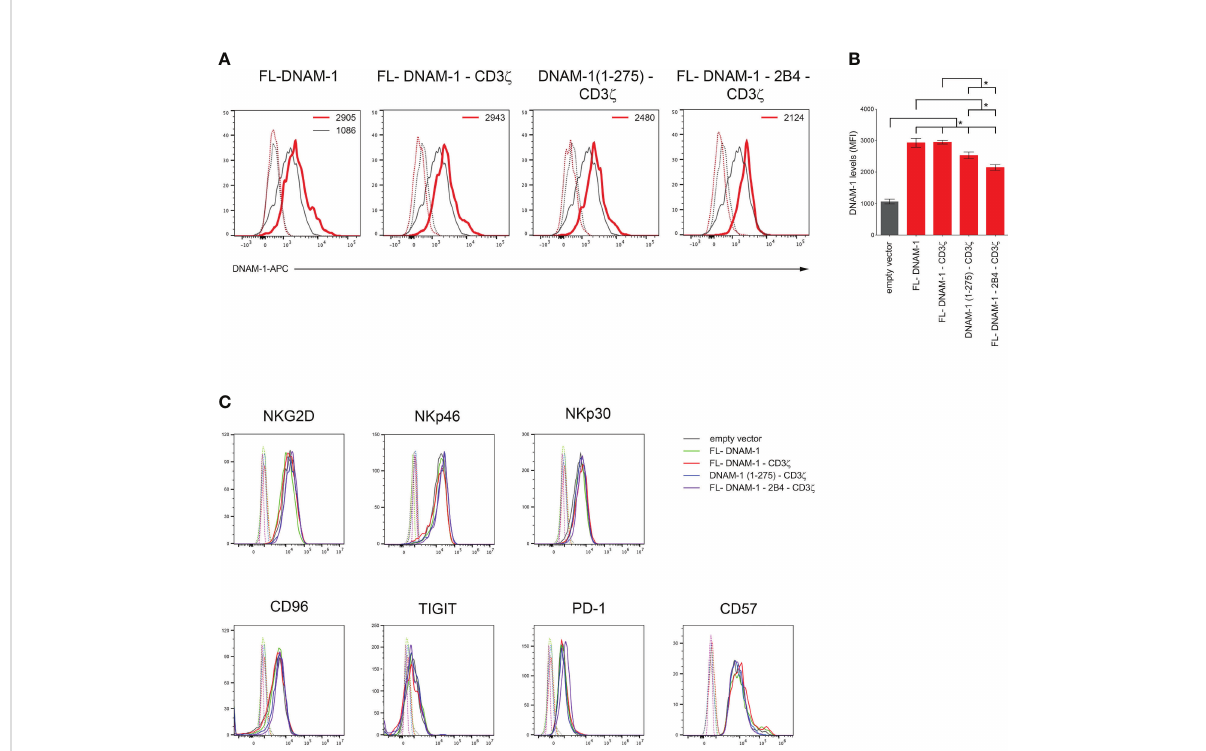
FIGURE 2 Enhanced surface expression of DNAM-1 receptor on DNAM-1-engineered NK cells. (A) Flow cytometry analysis of DNAM-1 surface expression in NK cells transfected with the indicated DNAM-1-based vectors (red) compared to that of NK cells transfected with empty vector (gray). Isotype-matched negative control antibody is displayed as gray and red dashed lines for NK cells transfected with empty vector and each indicated DNAM-1-based vector, respectively. A representative experiment of eight performed in NK cells isolated from independent healthy donors and transfected with DNAM-1-constructs is shown. (B) Summary of fl ow cytometry analyses performed in NK cells isolated by eight independent healthy donors and transfected with DNAM-1-based constructs. MFI, mean fl uorescence intensity. Mean ± SD; * p <0.05; p value (two-tailed non-parametric Mann-Whitney test). (C) Flow cytometry analysis of NKG2D, NKp46, NKp30, CD96, TIGIT, PD-1 and CD57 surface expression in NK cells transfected with the indicated DNAM-1-based vectors. Isotype-matched negative control antibody is displayed as dashed lines for NK cells transfected with empty vector and each indicated DNAM-1-based vector. A representative experiment of seven performed in NK cells isolated from independent healthy donors and transfected with DNAM-1-based vectors is